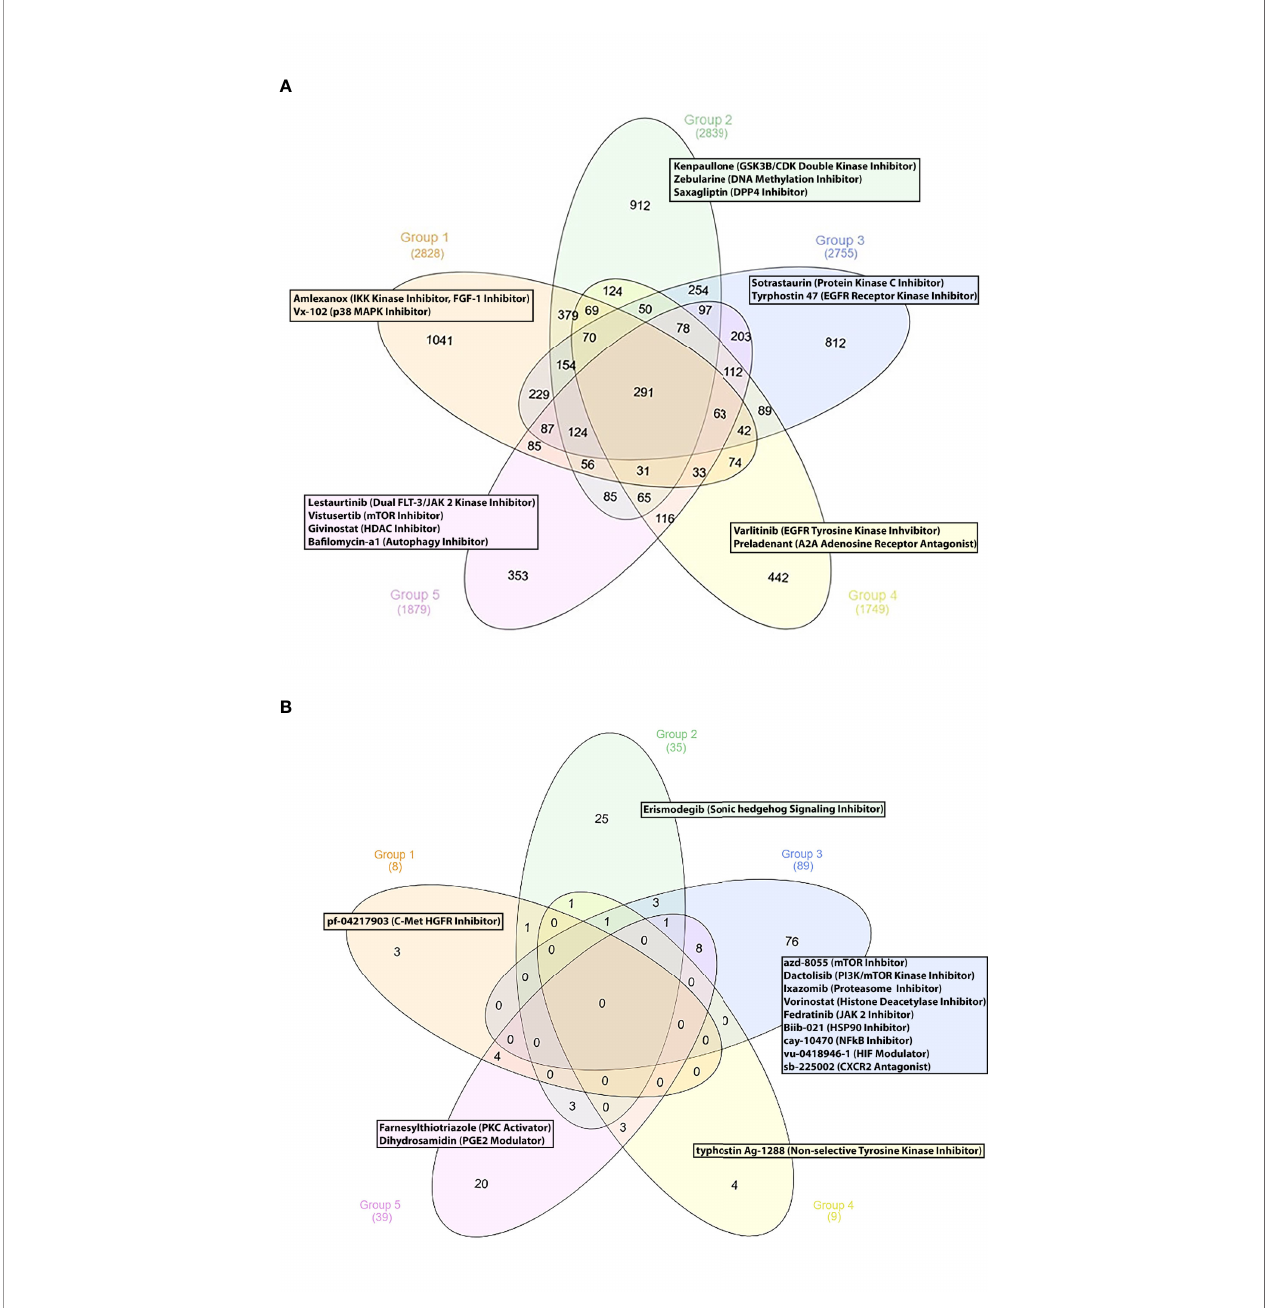
FIGURE 4 | (A) Group speci fi c compounds derived from iLINCS platform-based drug repurposing analysis. (B) Group speci fi c compounds derived from CLUE platform-based drug repurposing